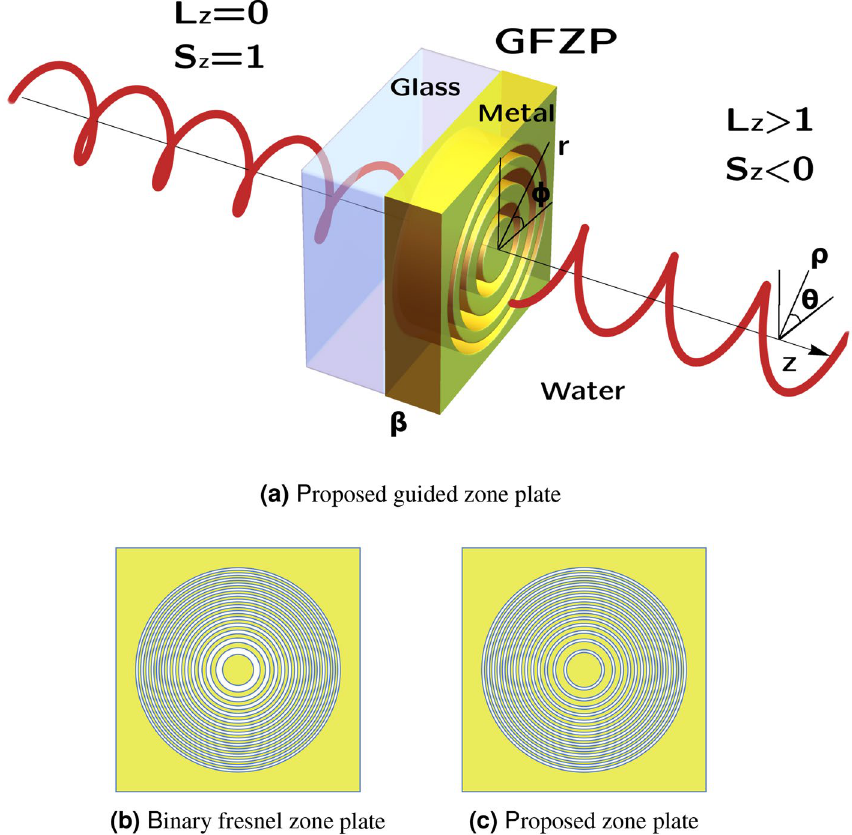
Figure 1. Schematic representation of the proposed system for spin to orbital angular momentum conversion. ( a ) SAM to OAM conversion in the proposed GFZP with the adequate selection of the width of the rings and the thickness β of the structure. (r, φ ) denote cylindrical coordinates for the propagation in the structure. ( ρ , θ , z) cylindrical coordinates for the propagation in the homogeneous medium. ( b , c ) show the bidimensional cut of a standard binary zone plate and the proposed zone plate with equal